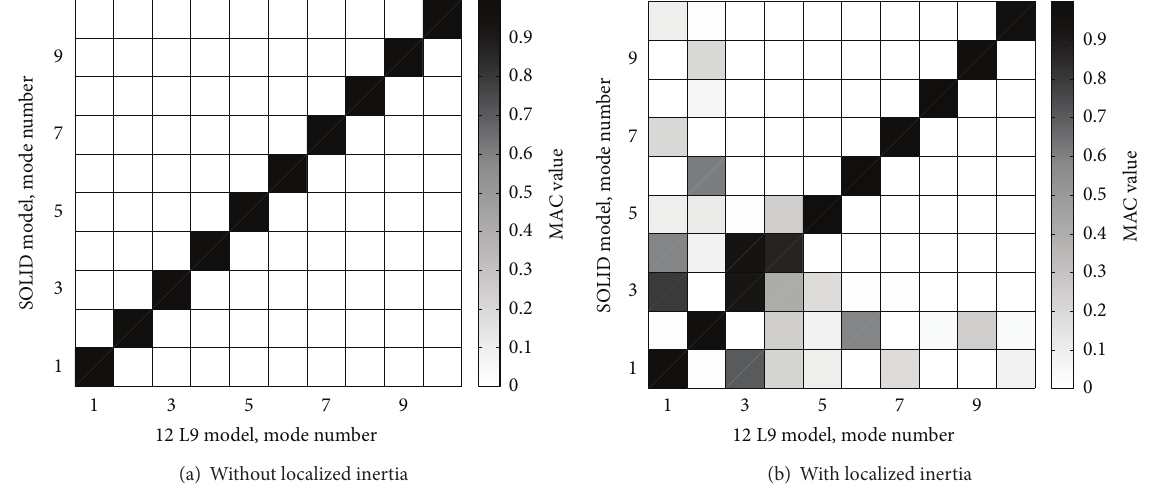
Figure 15: MAC values between the 12 L9 and FEM-3D models of the I-shaped beam.